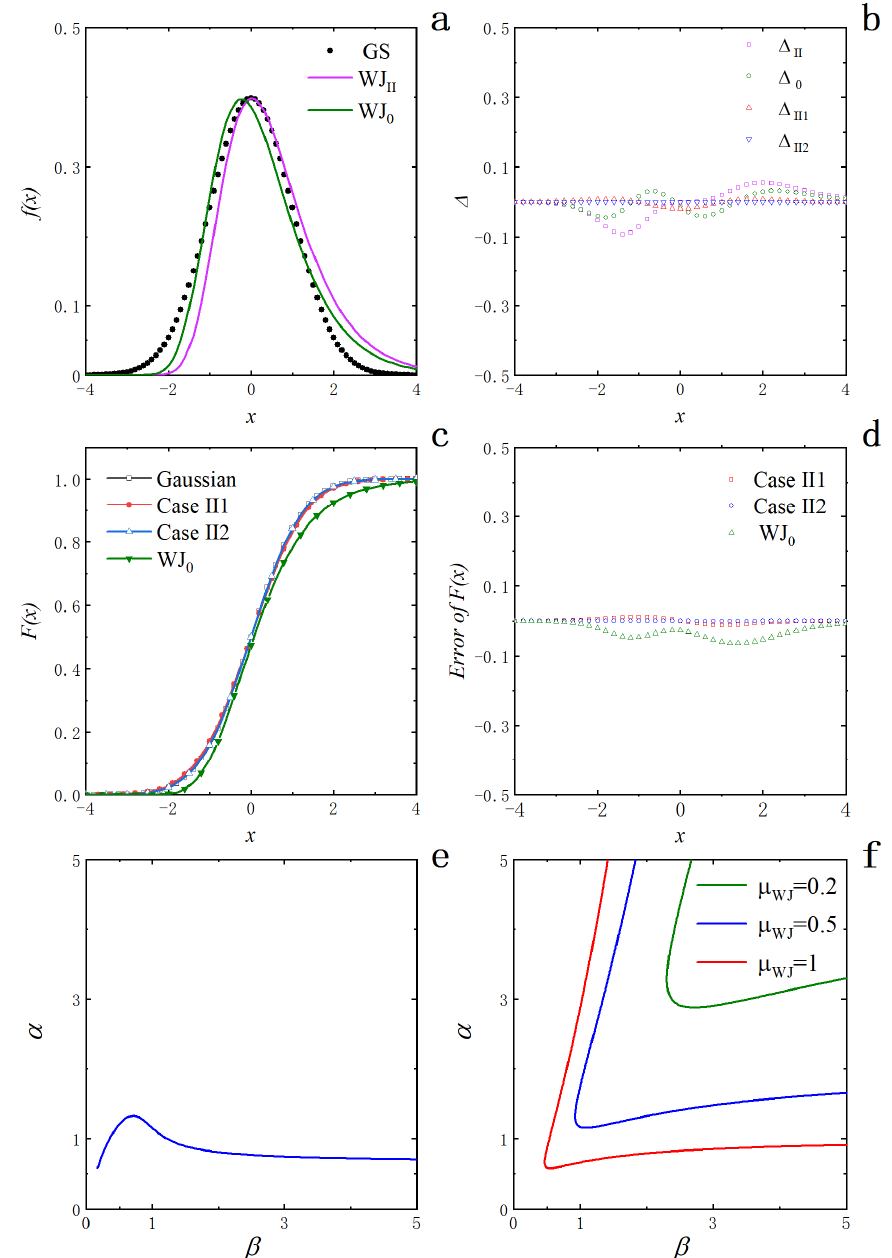
Figure 5. Analyses of expanding the WJ function by Method II around the point x = v . ( a ) WJ II based on the calculated parameters and WJ 0 from fitting of the independent variable ( x − v ) ; ( b ) ∆ II , Δ , Δ and Δ II2 for the residual scatters of the WJ function based on the calculated parameters, the WJ function fitting based on ( x − v ) , N ( ˆ µ II , ˆ σ II1 ) and N ( ˆ µ II , ˆ σ II2 ) versus N ( 0, 1 ) , respectively; ( c ) Gaussian, CaseII1, CaseII2 and WJ 0 for the cumulative probability distribution functions of N ( 0, 1 ) , N ( ˆ µ II , ˆ σ II1 ) , N ( ˆ µ II , ˆ σ II2 ) and the WJ function, separately; ( d ) CaseII1, CaseII2 and WJ 0 for the residual plots of the cumulative probability distribution functions of N ( ˆ µ II , ˆ σ II1 ) , N ( ˆ µ II , ˆ σ II2 ) and the WJ function obtained by fitting relative to N ( 0, 1 ) , correspondingly; ( e ) Relationship between α and β when ˆ σ II2 = 1 on the basis of Equation (19); ( f ) Relationship between α and β assuming ˆ µ II = 0 with µ WJ ∈ ( 0.2, 0.5, 1 ) in terms of Equation